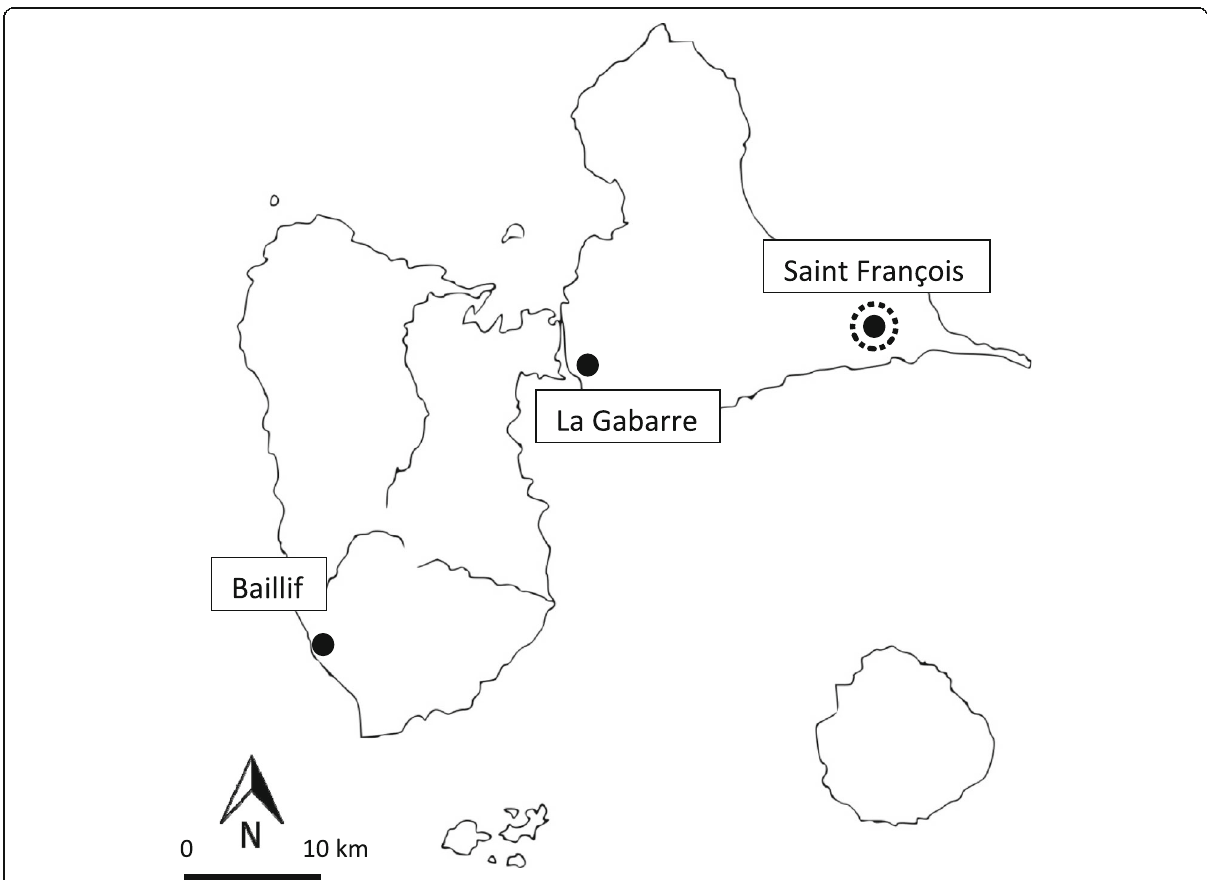
Fig. 1 Map of Guadeloupe archipelago (French West Indies), with locations of the three main open landfills (the dotted circle indicates a significant cluster within a 2-km radius of the